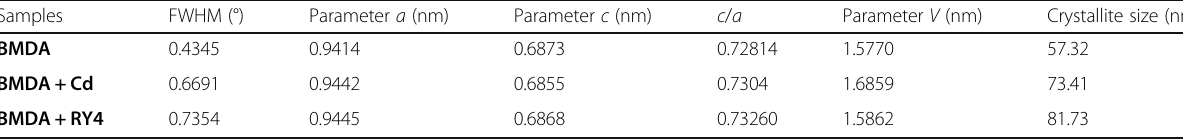
Table 1 Lattice parameters and crystallite sizes of BMDA powders before and after adsorption